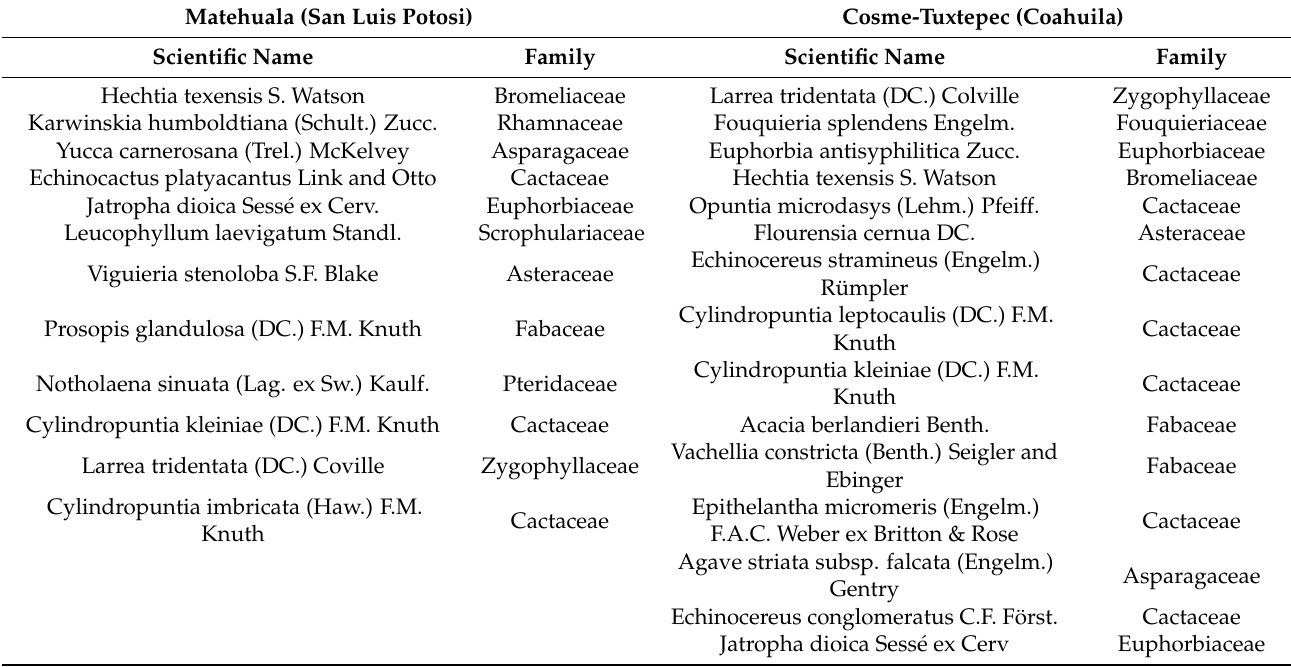
Table 3. Agave lechuguilla Torr. associated species in the harvesting area.